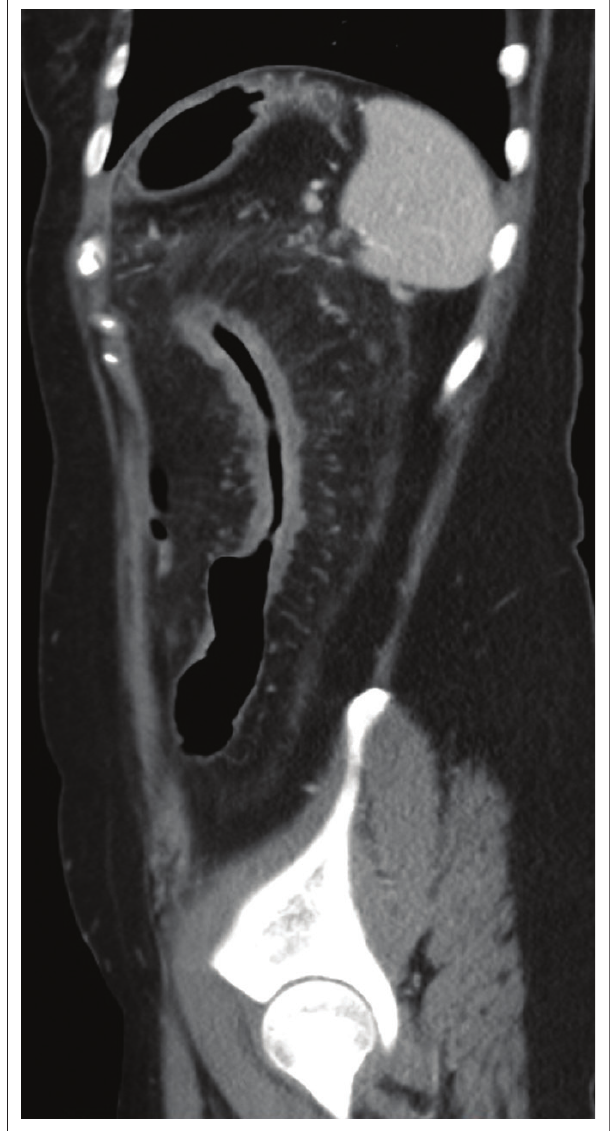
FIGURE 2: Sagittal.